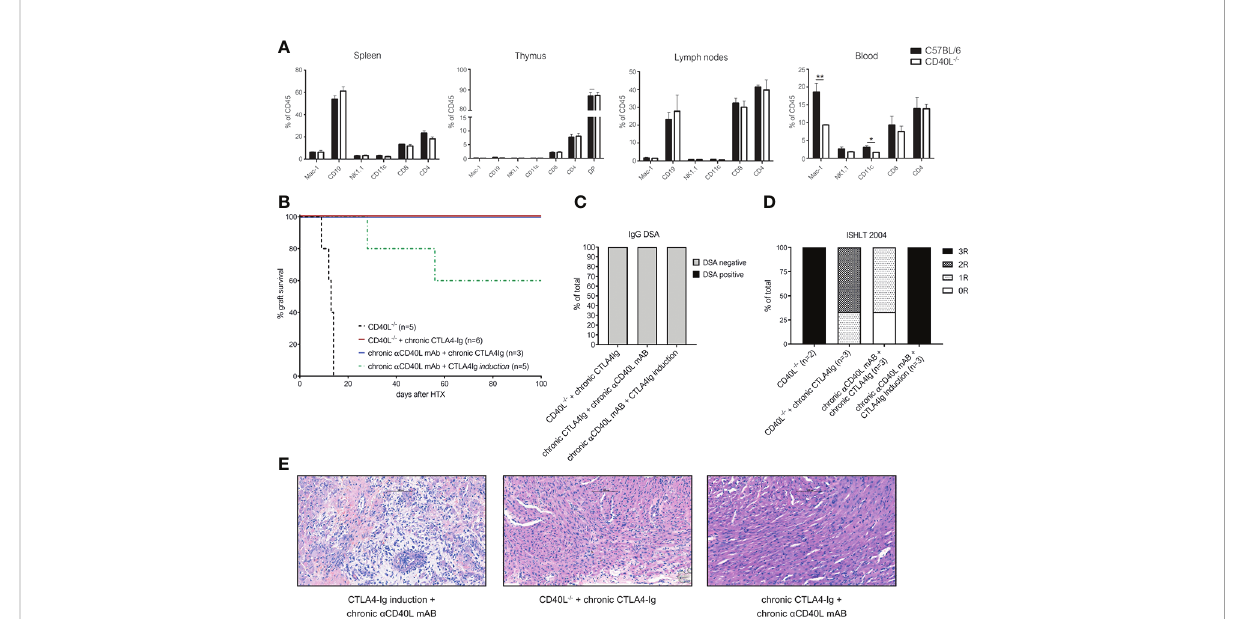
FIGURE 3 Chronic interception of both CD28-B7 and CD40-CD40L signaling leads to inde fi nite heart allograft survival, abrogates DSA formation and alleviates chronic rejection. (A) Distinct lymphocyte populations were analyzed in the spleen of naïve (C57BL/6) and CD40L knockout mice (CD40L -/- ). Bars illustrate mean percentage of indicated leukocyte populations within CD45 + leukocytes + SD. (B) Cardiac allograft survival in CD40L -/- recipients with (red line) or without (black dotted line) chronic CTLA4-Ig treatment and wild-type C57BL/6 recipients treated chronically with a CD40L and CTLA4-Ig (purple line) or chronic a CD40L and CTLA4-Ig induction (green dotted line). (C) Percentage of mice with detectable donor speci fi c IgG antibodies (DSA) at the time of rejection or end of long-term follow up. (D) ISHLT-2004 grading of cardiac allograft tissue sections explanted at the end of follow up at day 100. (E) Representative histological images of H&E stained tissue sections from long term surviving hearts of recipients treated with CTLA4-Ig induction and chronic anti-CD40L (left), chronic CTLA4-Ig in CD40L -/- mice (midle) and chronic CTLA4-Ig and anti-CD40L in wild-type mice (right). * indicates p<0.05; ** indicates